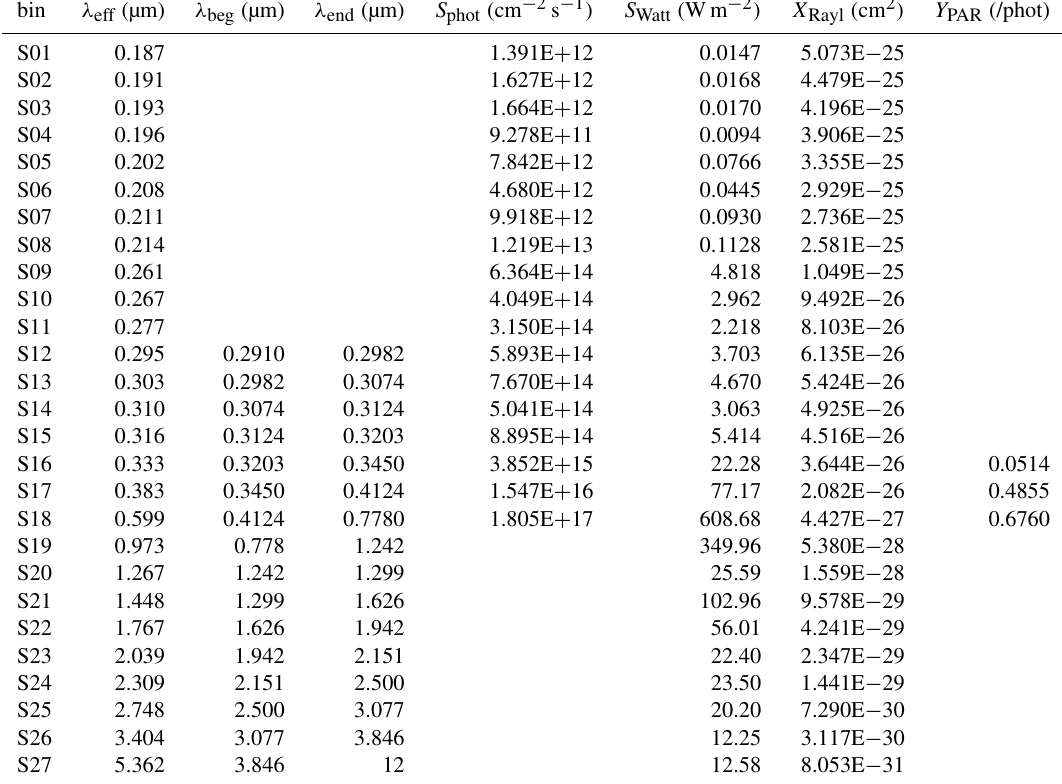
Table 1. Some key configuration parameters for Solar-J v7.5 wavelength bins: solar-flux-weighted wavelength ( λ eff) within the range be- tween λ beg and λ end , solar fluxes in photonscm − 2 s − 1 ( S phot ) and in Wm − 2 ( S watt ) , Rayleigh cross section ( X Rayl ) , and yields for photo- synthetically active radiation ( Y par